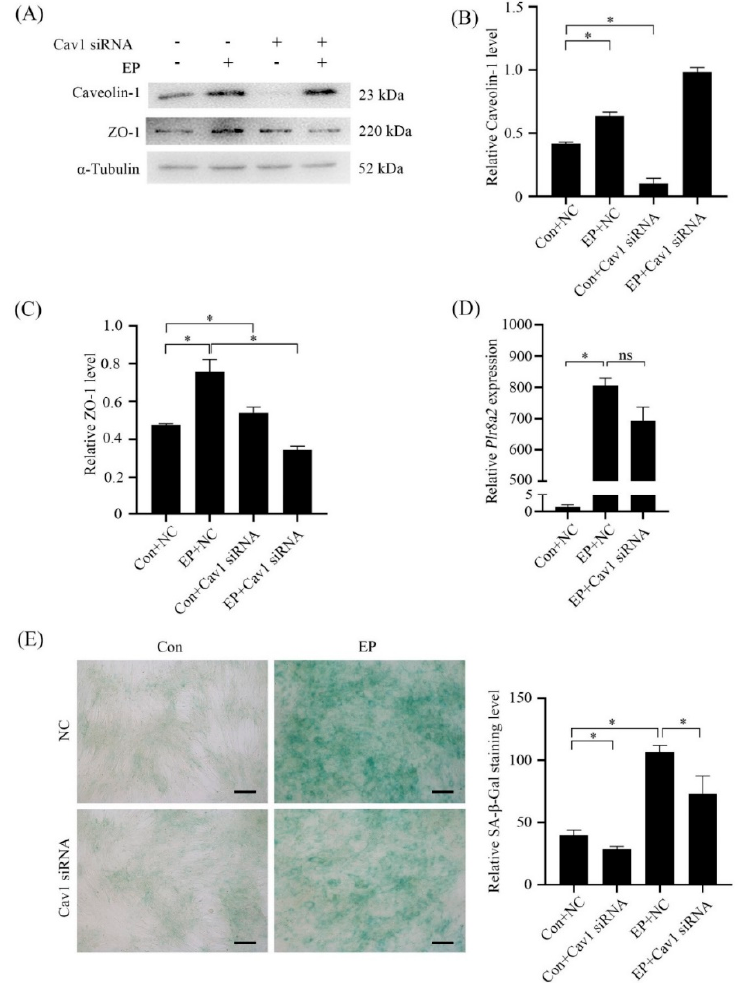
Figure 6. Effects of Caveolin-1 siRNA on mouse in vitro decidualization. ( A ) Western blot analysis of Caveolin-1 and ZO-1 proteins in stromal cells under in vitro decidualization for 2 days. ( B ) Semi- quantitative analysis of Caveolin-1 protein level in ( A ). ( C ) Semi-quantitative analysis of ZO-1 level in ( A ). ( D ) Real-time PCR analysis on the effect of Caveolin-1 siRNA on Plr8a2 mRNA level in stromal cells under in vitro decidualization for 2 days. ( E ) SA- β -Gal staining and Semi-quantitative analysis in stromal cells under in vitro decidualization for 6 days. NC, negative control. *, p < 0.05; ns, not significant; Scale bar = 20 µ